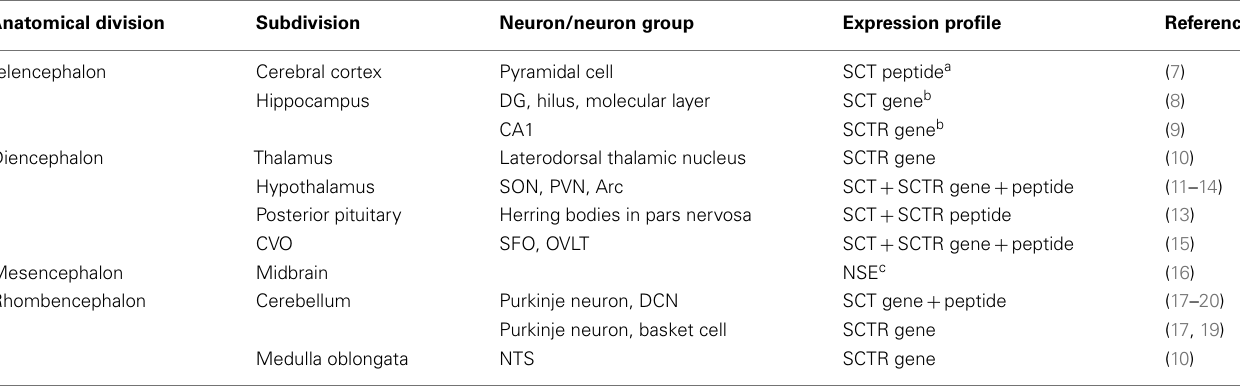
Table 1 | Brain distributions of SCT and SCTR